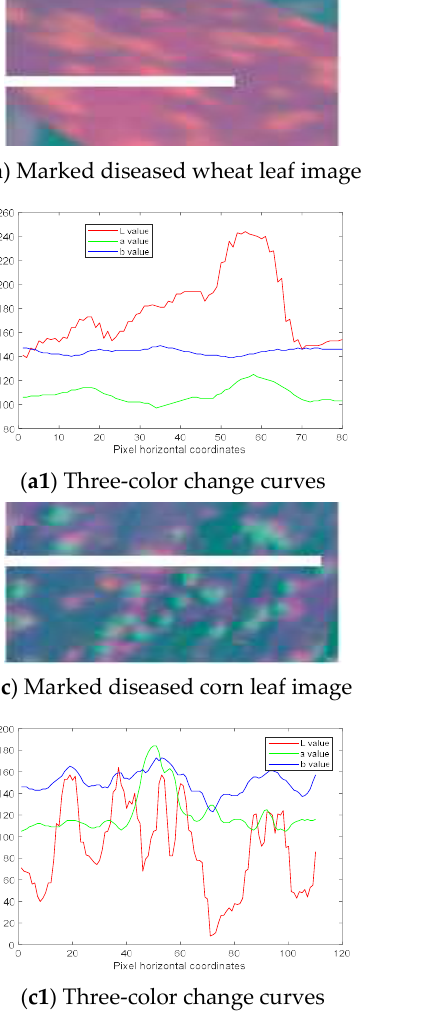
Figure 3. L, a, and b changes of the diseased leaves in the lab color space.